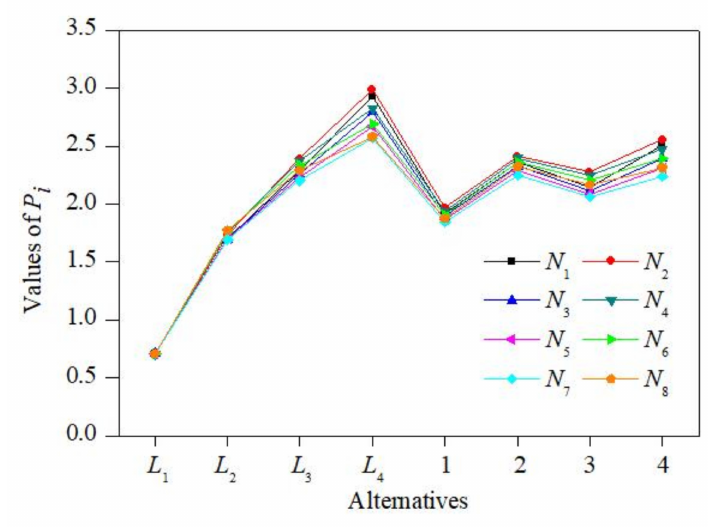
Figure 5. Values of P i under different values of α and β for each